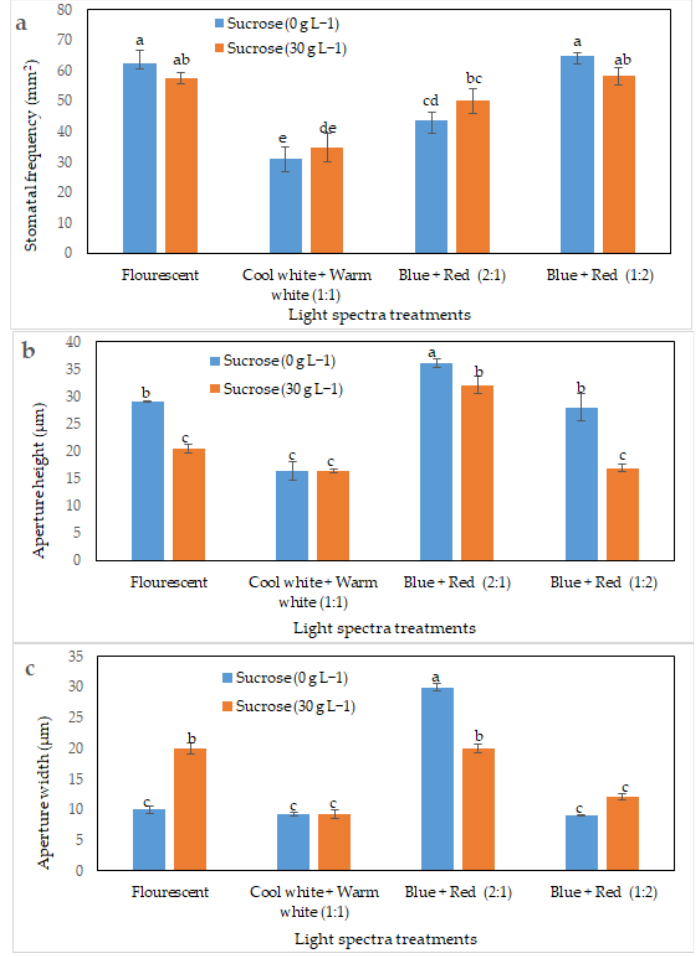
Figure 4. ( a ) Leaf stomatal density and ( b ) aperture length and ( c ) width of in vitro blackberry plantlets according to light spectra and sucrose concentration treatments. Data represent means ± standard errors. Different letters show significant differences at p ≤ 0.05.